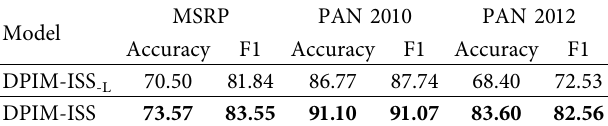
Table 5: The effect of lexical features on DPIM-ISS.